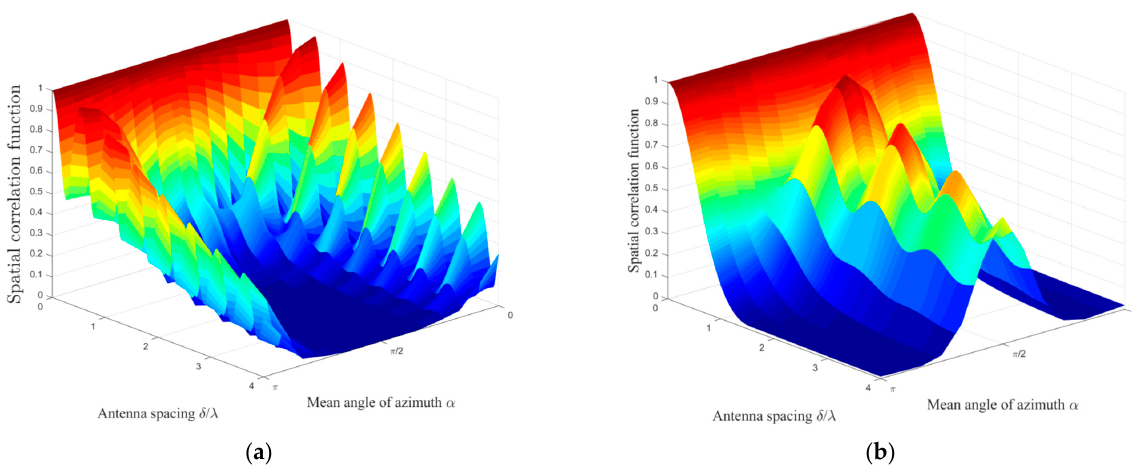
Figure 8. Analytical results of the spatial CF ρ pq , p’q’ ( δ T , δ R ) of the proposed model in a non-isotropic scattering environment for different antenna spacings δ / λ and different mean angles α 0 with ( a ) θ T = θ R = 0 and ( b ) θ T = θ R = π /4.